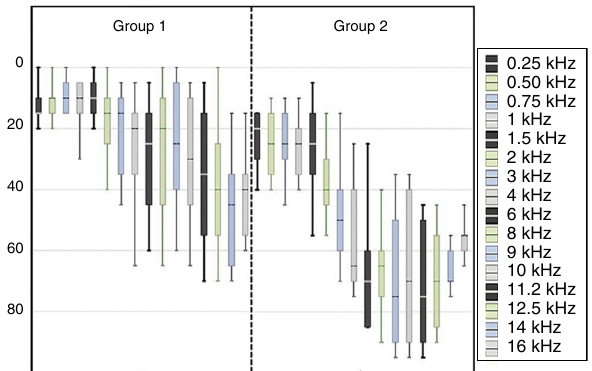
Figure 2 Values of mean, maximum and minimum audiomet- ric thresholds of the left ear (LE) in the stages initial assessment, monitoring and final assessment of the groups G1 and